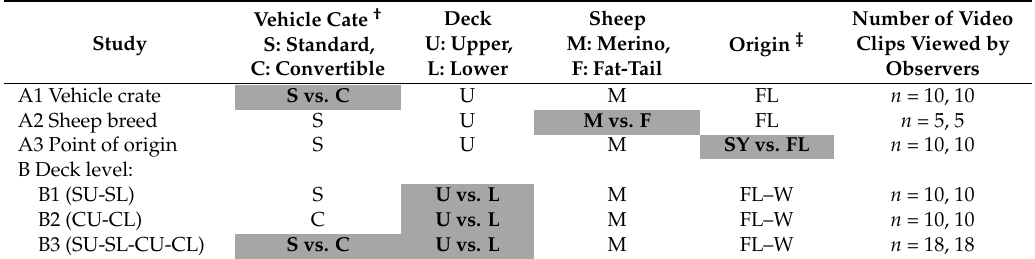
Table 1. Description of the treatment comparisons carried out. Bold text indicates the comparison made for each